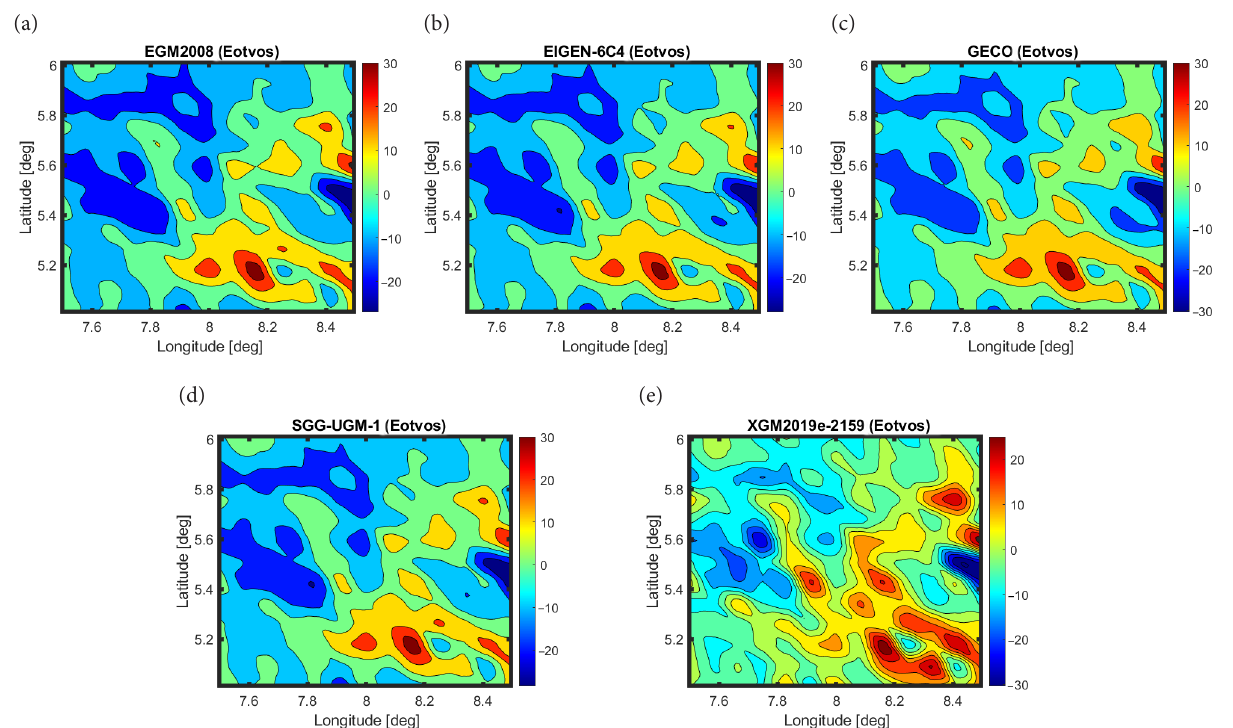
Figure 10. GGM-derived gravity gradient map of the Afikpo Basin computed